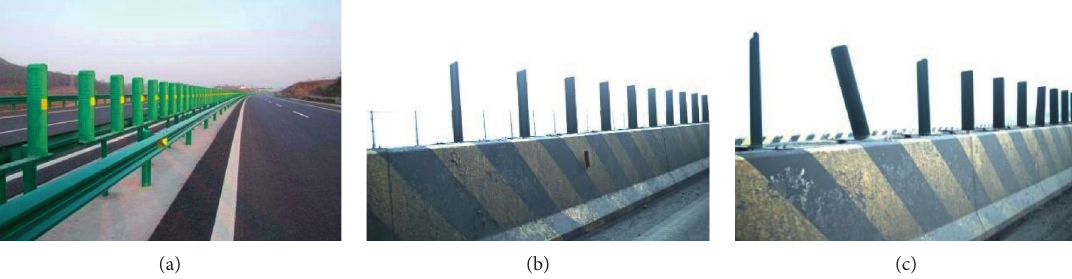
Figure 1: The highway anti-glare panel: (a) anti-glare panel; (b) anti-glare panel; (c) inclined anti-glare